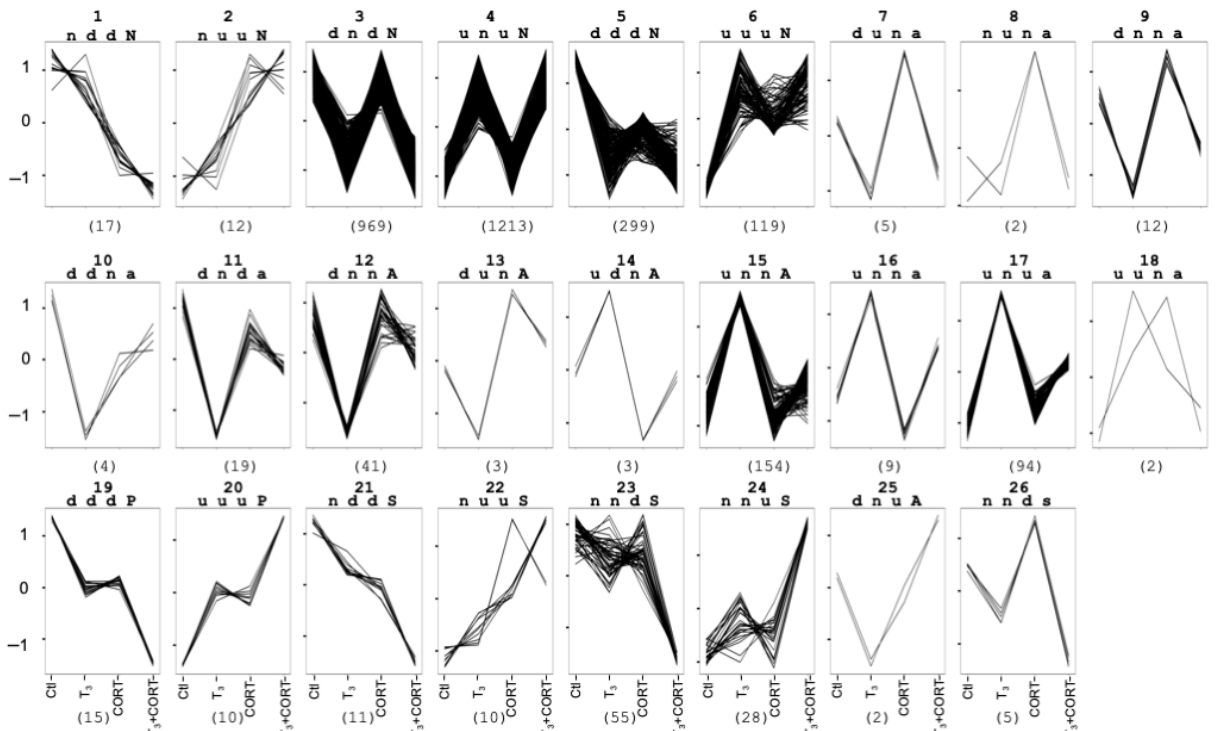
Figure 2. Expression profile-based clustering of the DE genes reveals crosstalk between T 3 and CORT signaling. The first three letters describe the expression changes compared to the control. The fourth letter illustrates the type of crosstalk response: “N” for no crosstalk, “P” for potentiated, “A” for mutually antagonized, “a” for singly antagonized, and “s” or “S” for synergistic. With “s”, gene expression can be also regulated with each hormone individually, whereas, with “S”, gene regulation is strictly dependent on the action of both hormones simultaneously.